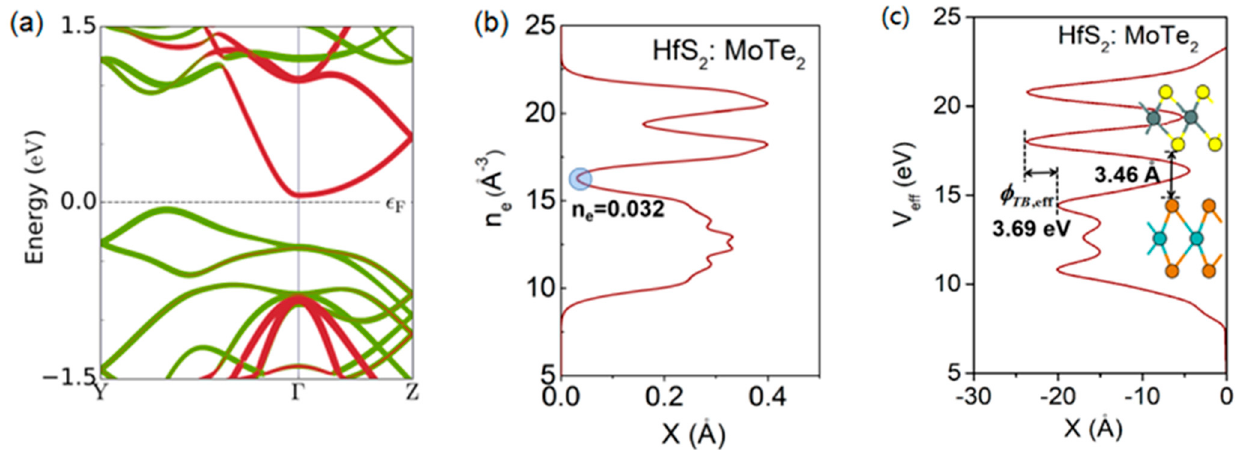
Figure 2. ( a ) Band structures of the HfS 2 /MoTe 2 heterojunction. The electronic states contributed by HfS 2 and MoTe 2 are marked by the red and green curves, respectivel y. The Fermi level is referenced to zero. ( b ) Average electron density, n e . ( c ) Effective potential, V eff . Figure 1. Atomic configuration of a monolayer MoTe 2 FET with HfS 2 located in the source region.